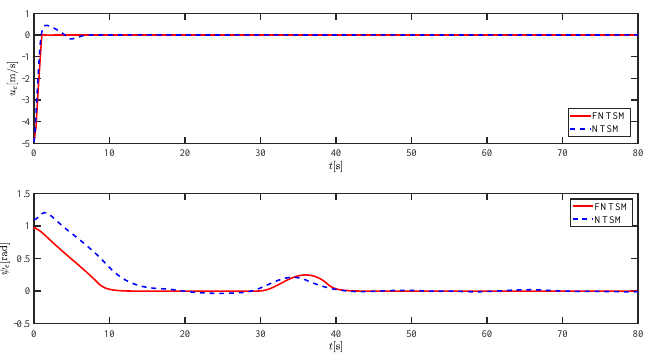
Figure 30. Sideslip angle estimations under severe disturbance.